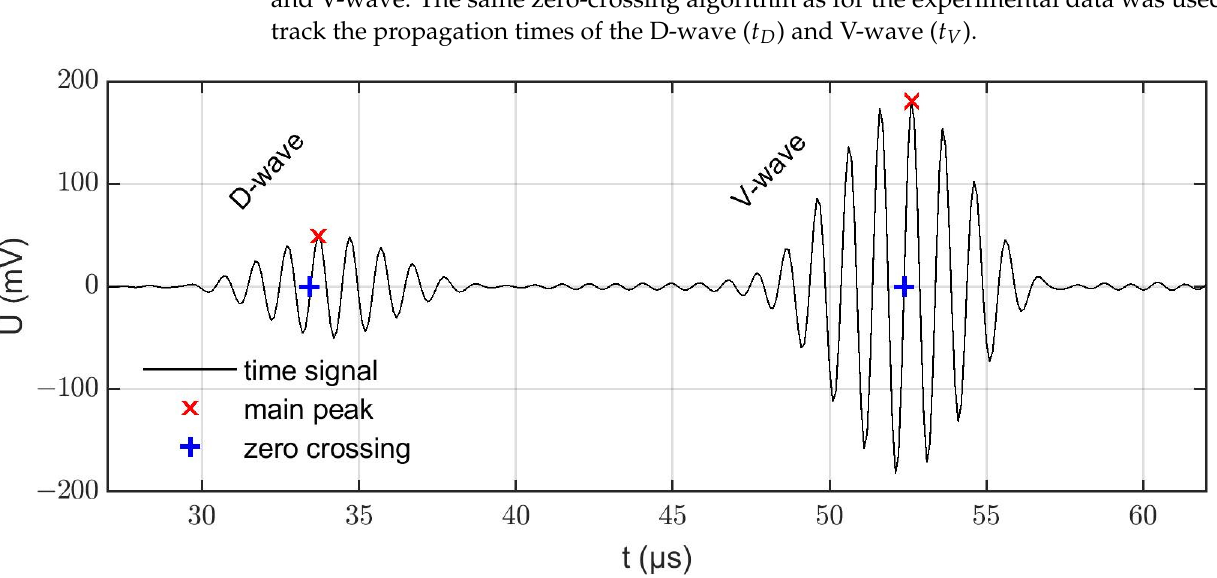
Figure 3. Simulated voltage signal (U) at the receiver at 20 °C and without a limescale layer with D-wave (29–39 µs) and V-wave (47–57 µs) contributions.